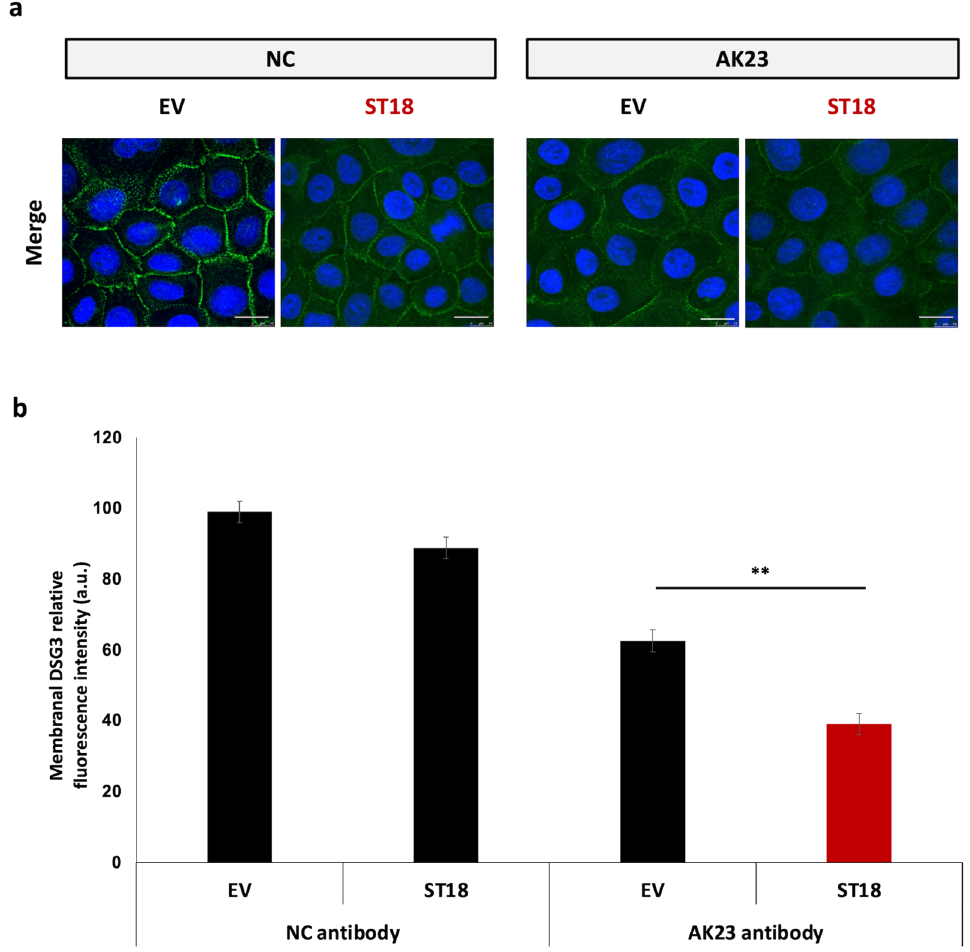
Figure 1. ST18 enhances antibody-mediated DSG3 down-regulation in keratinocytes. ( a ) NHEKs were transfected with an ST18 expression vector (ST18) or with a control empty vector (EV); 24 h post transfection, cells were exposed to AK23 for 12 h and were then fixed and immunostained for DSG3 (green signal) and DAPI (blue signal); ( b ) Expression of DSG3 was quantified by ImageJ software. Results represent the mean ± SE of three independent experiments (**p < 0.01 by 2-tailed t test; scale bar =